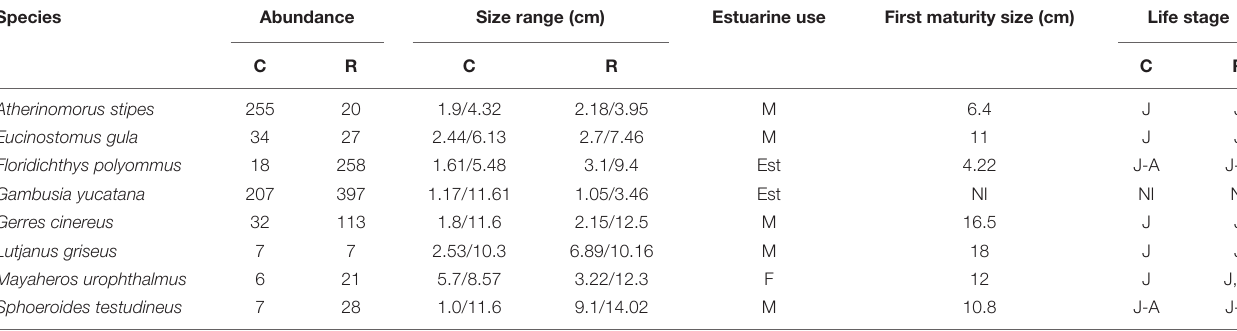
TABLE 1 | Abundance, size range (min–max), and juvenile use of mangrove site (first maturity size) of fish species in mangrove